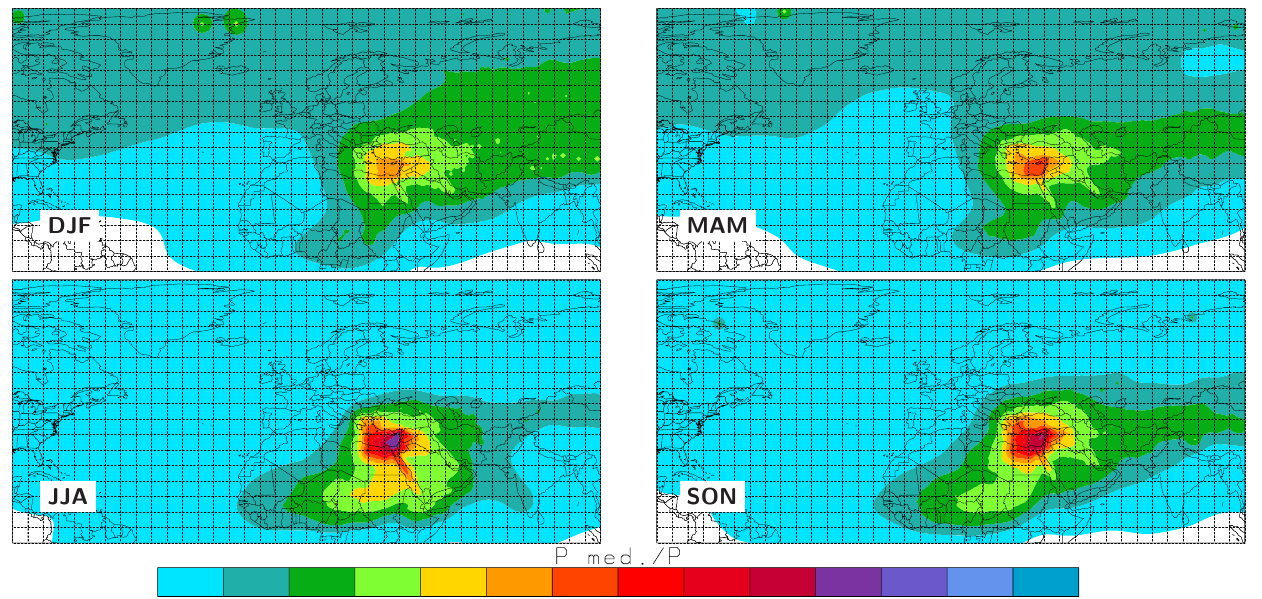
Fig. 14. Same as Fig. 12 (precipitation fraction) but for the eastern Mediterranean basin.